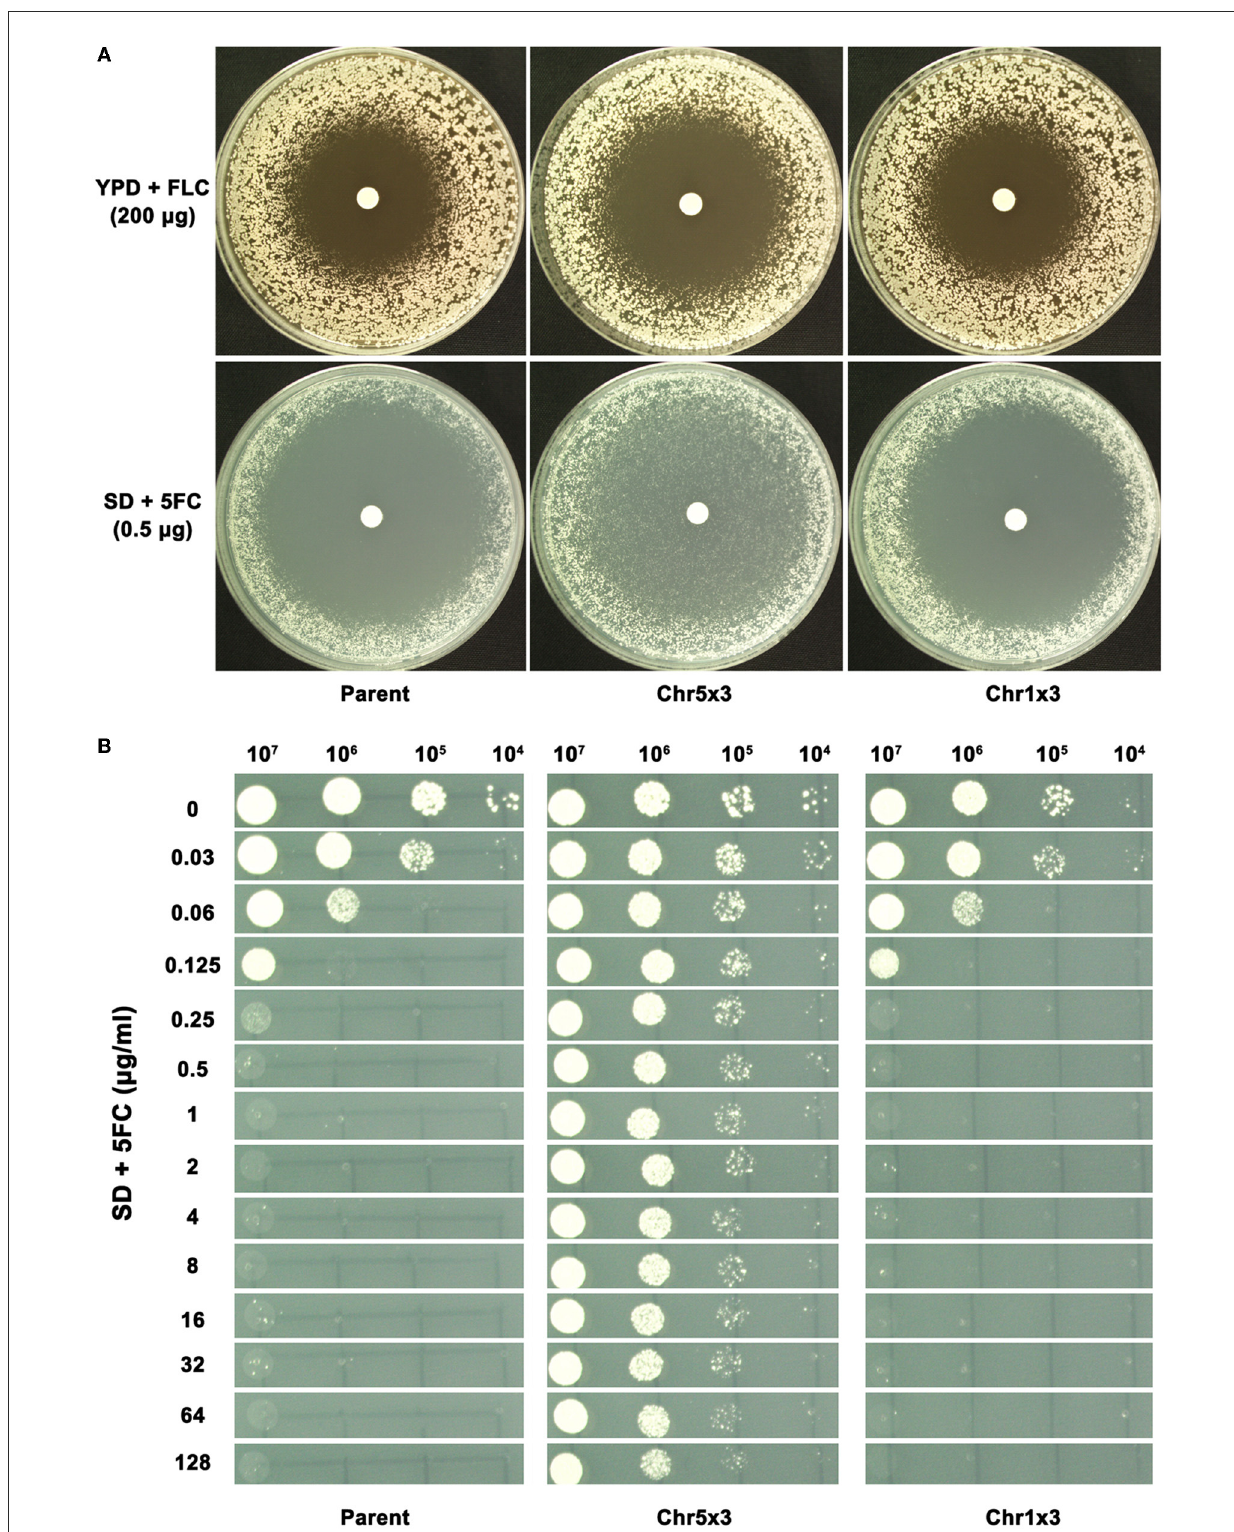
FIGURE3 Chromosome 5 trisomy confers tolerance to 5-flucytosine. In (A) , disk diffusion assays were performed to compare aneuploids and the parent for tolerance to fluconazole (FLC) and 5-flucytosine (5FC). YPD and SD plates were used for testing FLC and 5FC, respectively. In (B) , spot assays were performed using a wide range of 5FC concentrations (0.03 µ g/ml − 128 µ g/ml). A total of 3 µ l of 10-fold serial dilutions were spotted on the plates. In (A) and (B) , the plates were incubated at 37 ◦ C for 72h and then